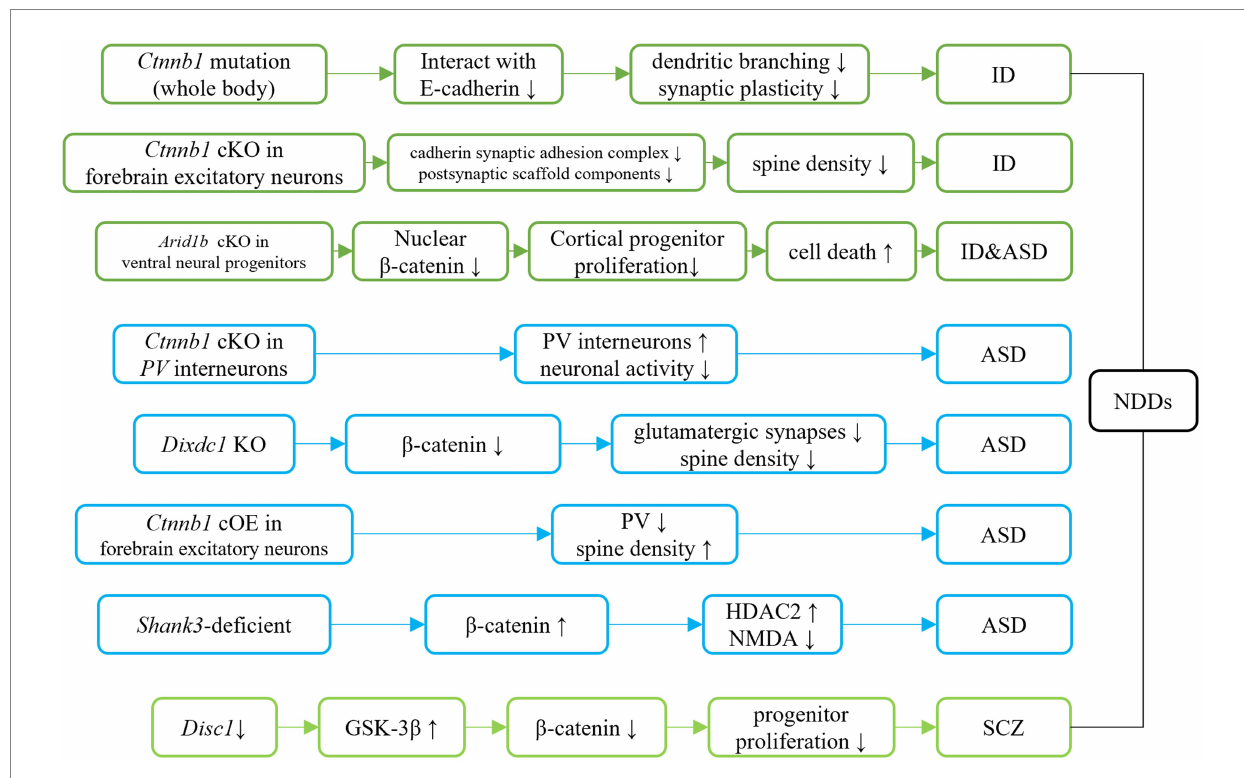
FIGURE 4 Ctnnb1 related signaling pathways in neurodevelopmental disorders. Dark green represents the direct/indirect link of Ctnnb1 to ID. Direct evidence of down-regulation of β -catenin suggests the β -catenin pathway involves ID. Indirect evidence indicates the Tcf4 mutation causes ID-like phenotypes in mice via down-regulation of β -catenin. Light blue represents the direct/indirect link of Ctnnb1 to ASD. Ctnnb1 deletion in PV interneuron results in social deficits in mice. Dixdc1 mutation and Shank3 mutation causes autism-like behaviors in mice via the suppressed Wnt/ β -catenin signaling pathway. Disc1 deficiency impairs progenitor proliferation through the downregulation of β -catenin and introduces schizophrenia-like